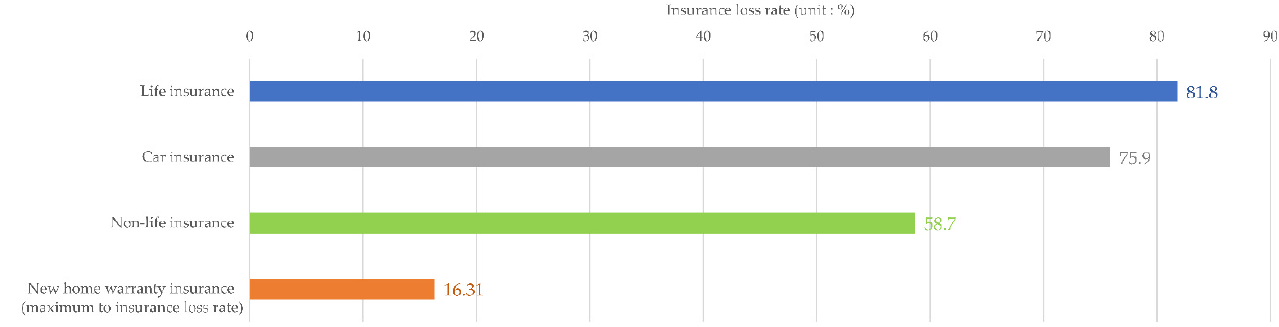
Figure 5. Comparison of insurance loss rates among di ff erent types of insurance.